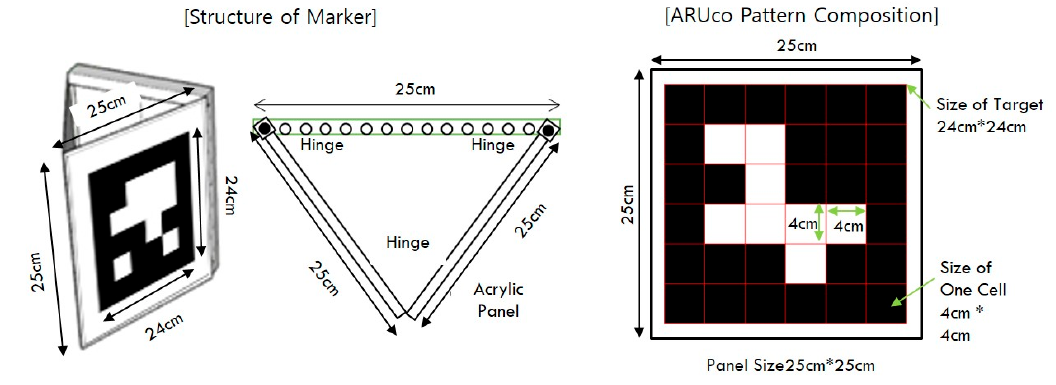
Figure 8. Size of marker and pattern.